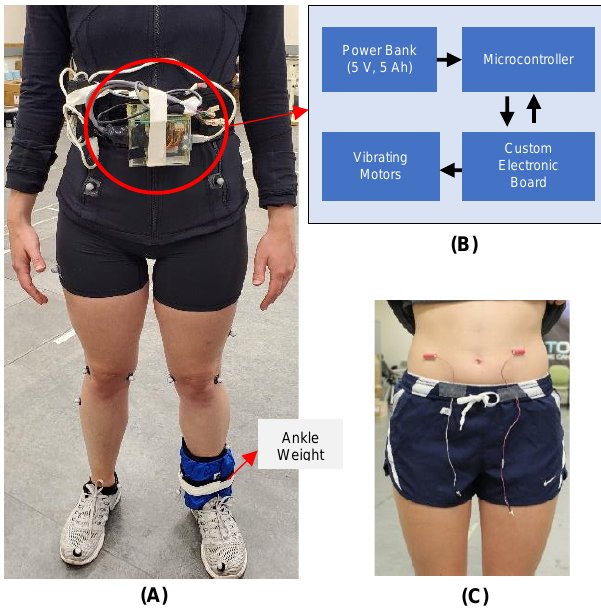
Figure 1: Equipment and Instrumentation for RVS system. A : Set- up of the BFB system on a participant; B : Microcontroller-based Control Unit, including the custom electronic board, and power supply; C : Vibrating Unit (motors) located at the lower